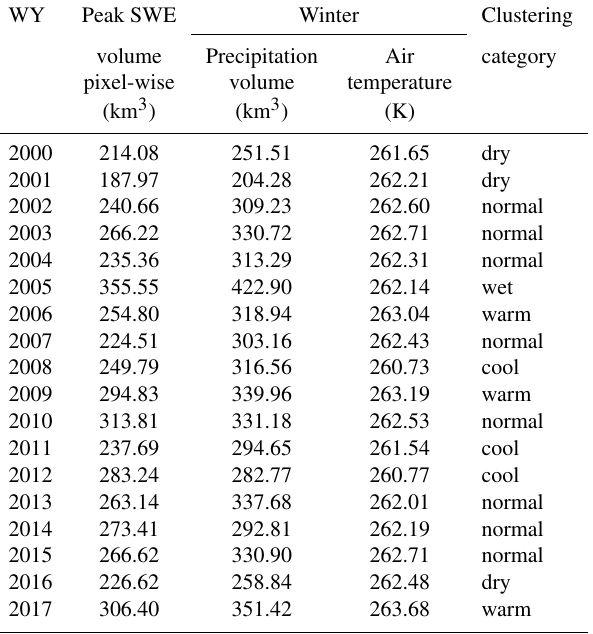
Table 2. HMA pixel-wise peak SWE volume, winter precipitation volume and winter air temperature, with each year categorized as dry/normal/wet/warm/cool based on clustering classification.